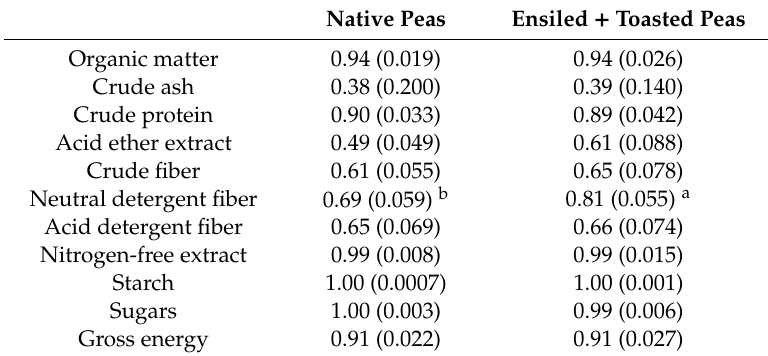
Table 5. Total tract apparent digestibility of energy and proximate nutrients in native and ensiled + toasted field pea grains. Native